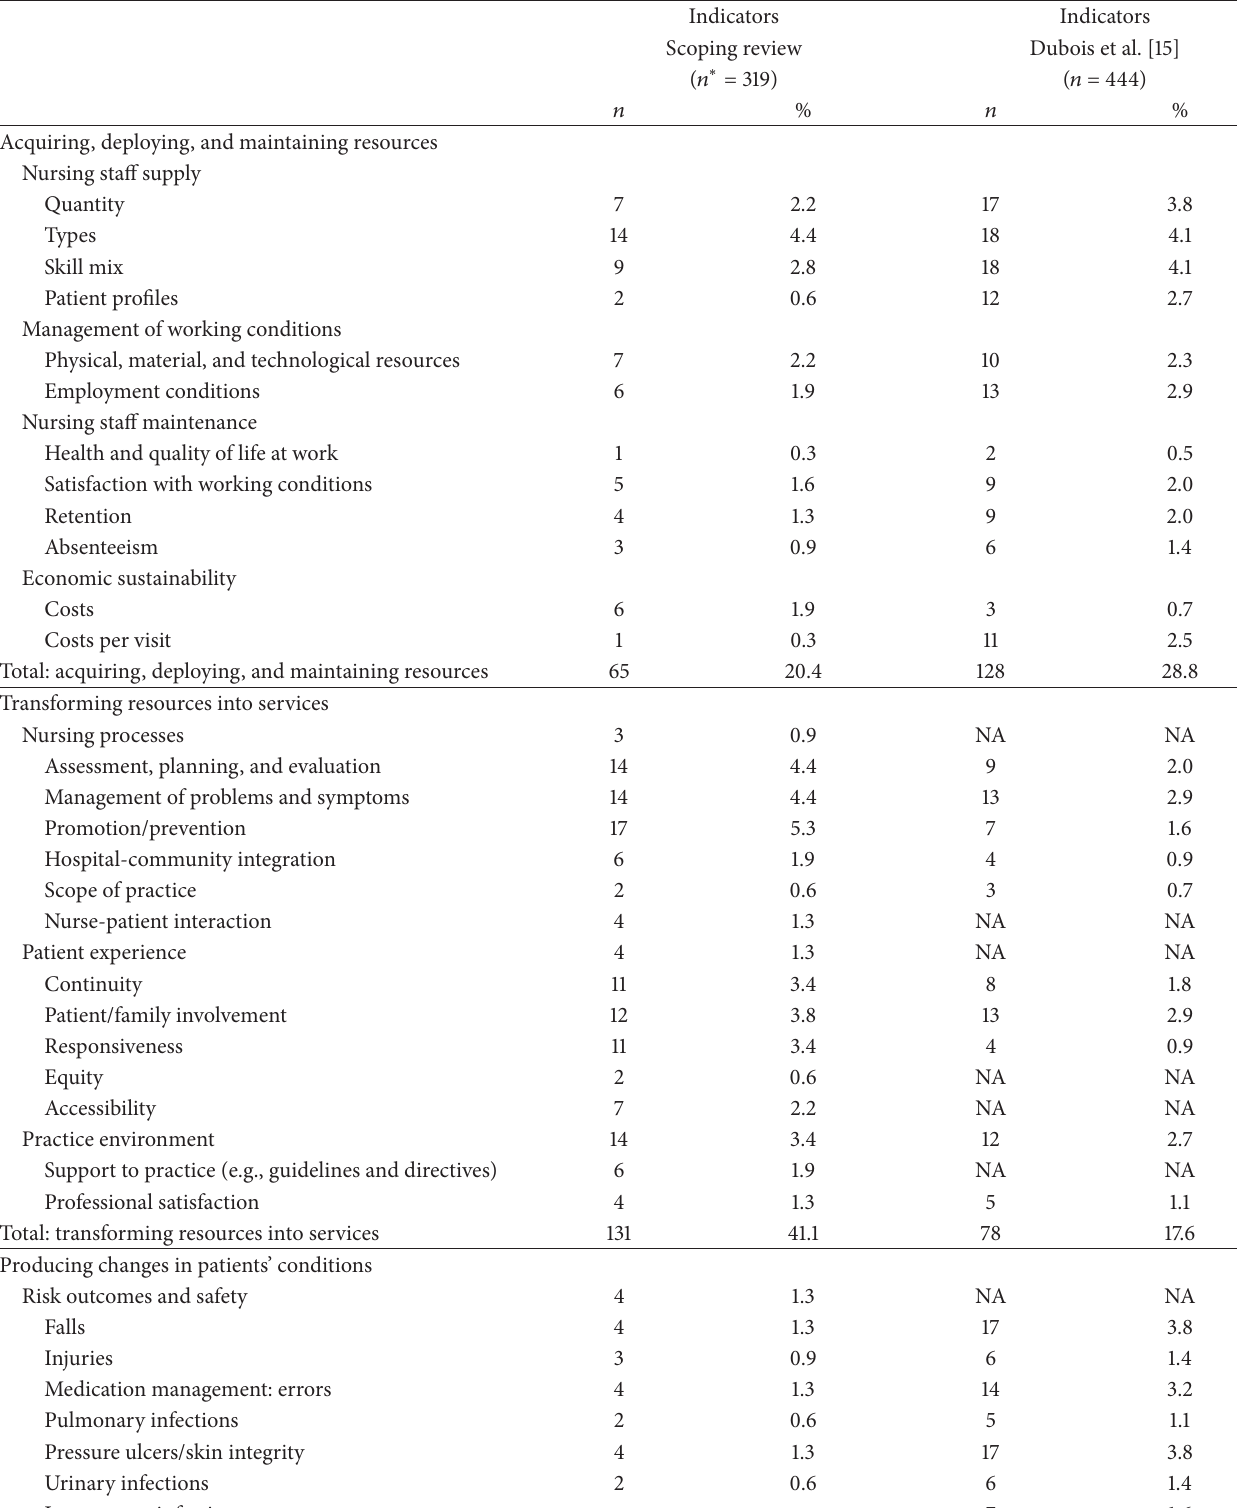
Table 1: Comparison of indicators from this scoping review and those of Dubois et al. [15]. Indicators